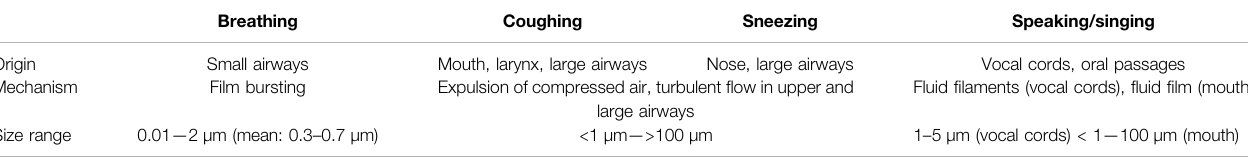
TABLE 1 | Exhaled aerosols generated from human respiratory activities. Breathing